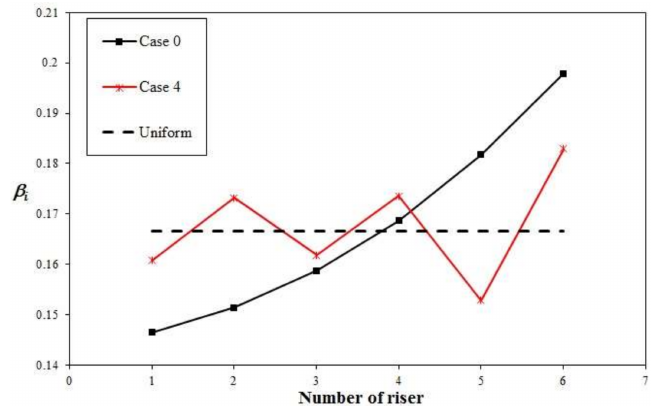
Figure 12. Average velocity in riser tubes at different volumetric flow rates. Flow distribution comparison between Case 0 and Case 4 at 10